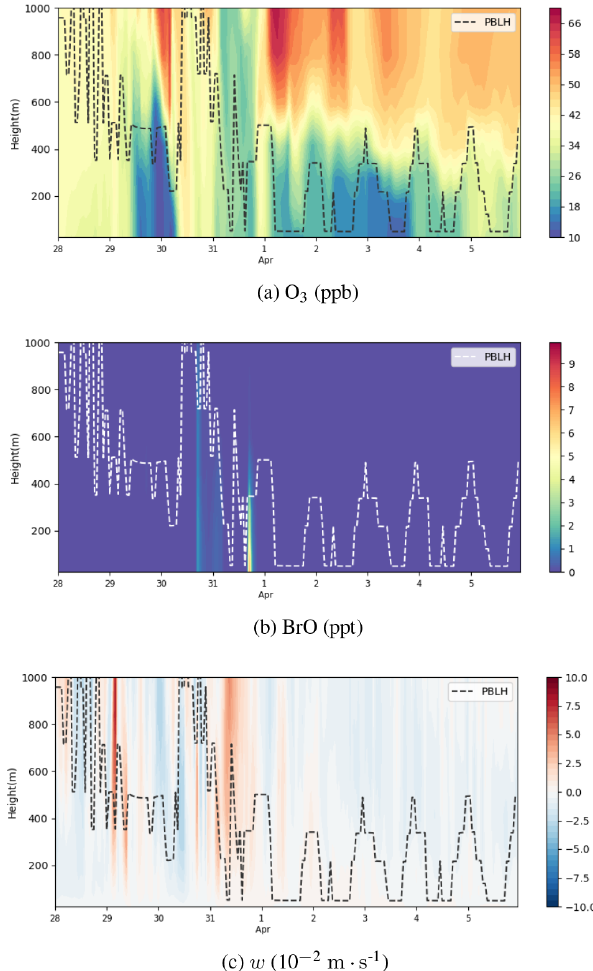
Figure 11. Vertical profiles of ozone (ppb), BrO (ppt), and vertical wind speed w (10 − 2 ms − 1 ) from 28 March to 6 April 2019 at Bar- row. The dotted line represents the local planetary boundary layer height (PBLH). A positive w represents an ascending tendency of air parcels, while a negative w denotes a descending tendency of air